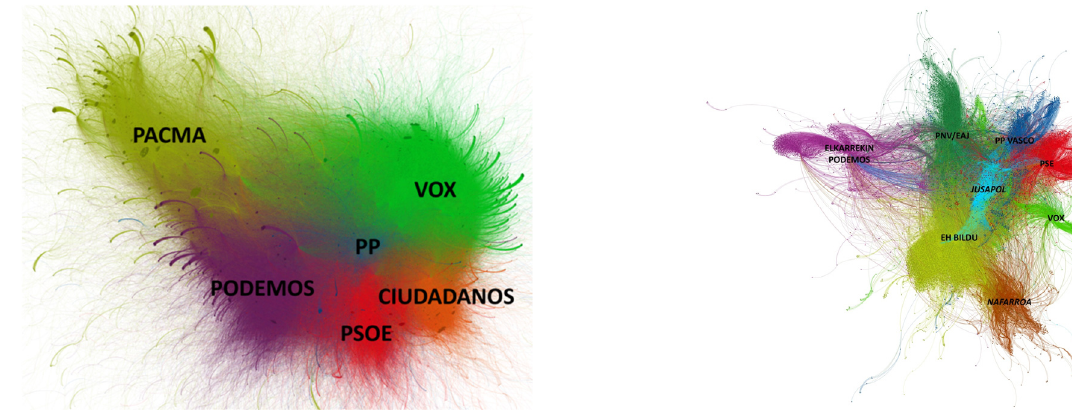
Figure 1. Network of mentions to political parties on Twitter during an electoral campaign (April 2019, Spain) in two different spheres of influence. Source: Own elaboration with Gephi software.